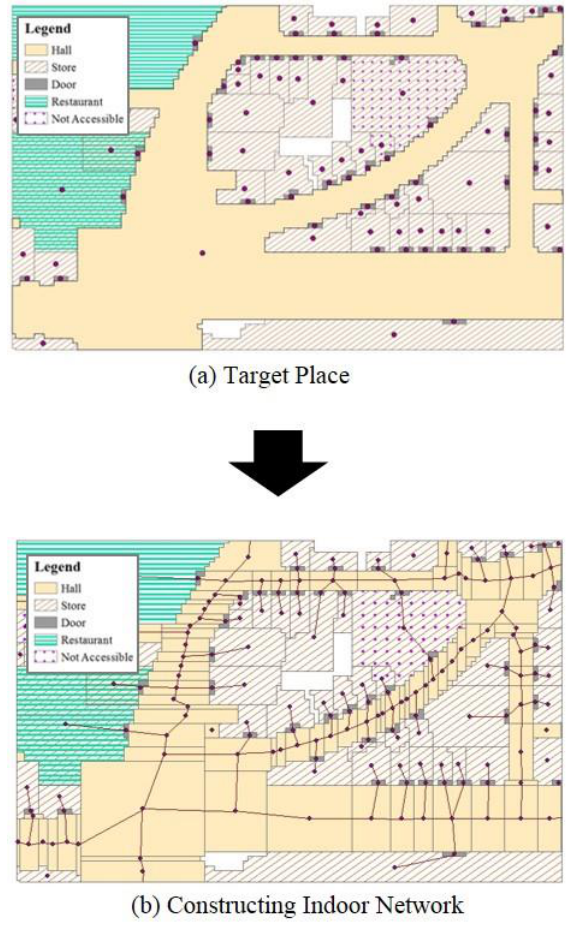
Figure 4. Result of subspacing based on transition space types in shopping mall (COEX